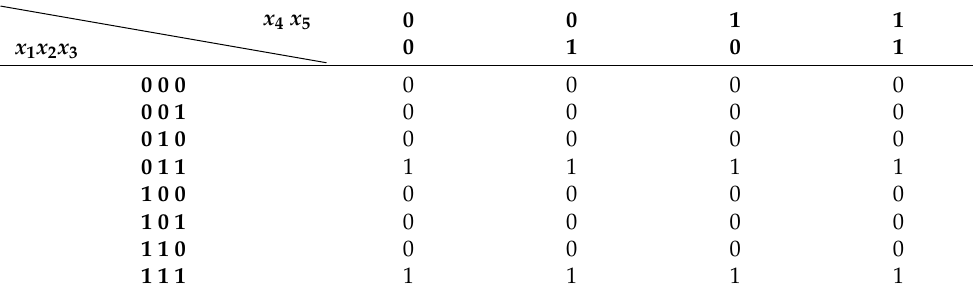
Figure 4. Fuzzy Decision Tree (FDT) for the investigated data. Table 9. The structure function of the system for evaluation of COVID-19